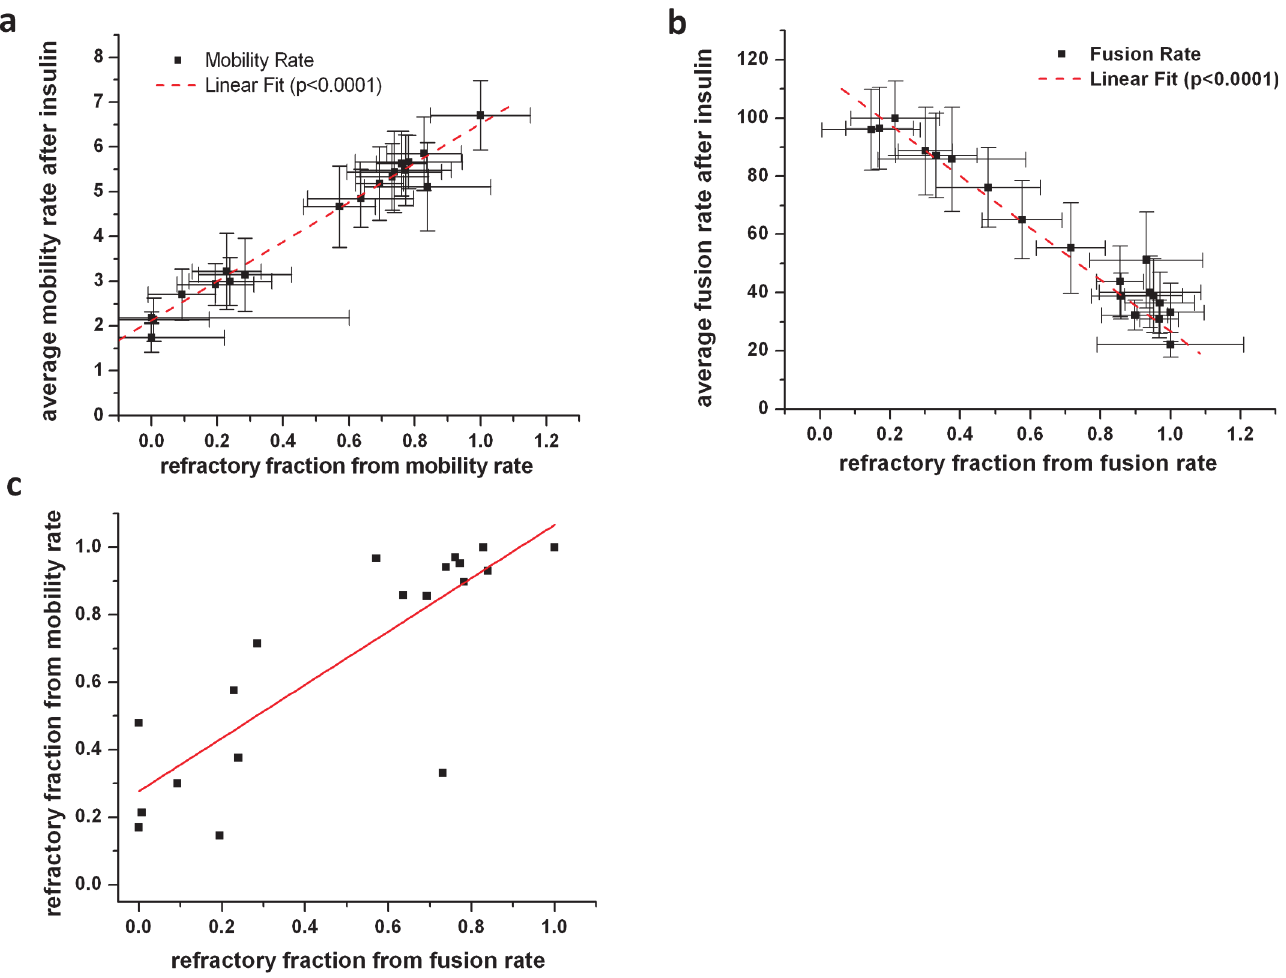
Fig 8. The average insulin response of the population of adipose cells (measured per subject) is determined by the change in the fraction of refractory cells, defined as the basal-like fraction present in the insulin stimulated state and derived from distributional fitting of individual subject insulin responses. The average values for both mobility (a) and fusion (b) rates measured for populations of cells was linearly correlated with the fraction of refractory cells. (c) The correlation between refractory fractions determined from mobility and fusion data (R 2 = 0.67) does not pass through the